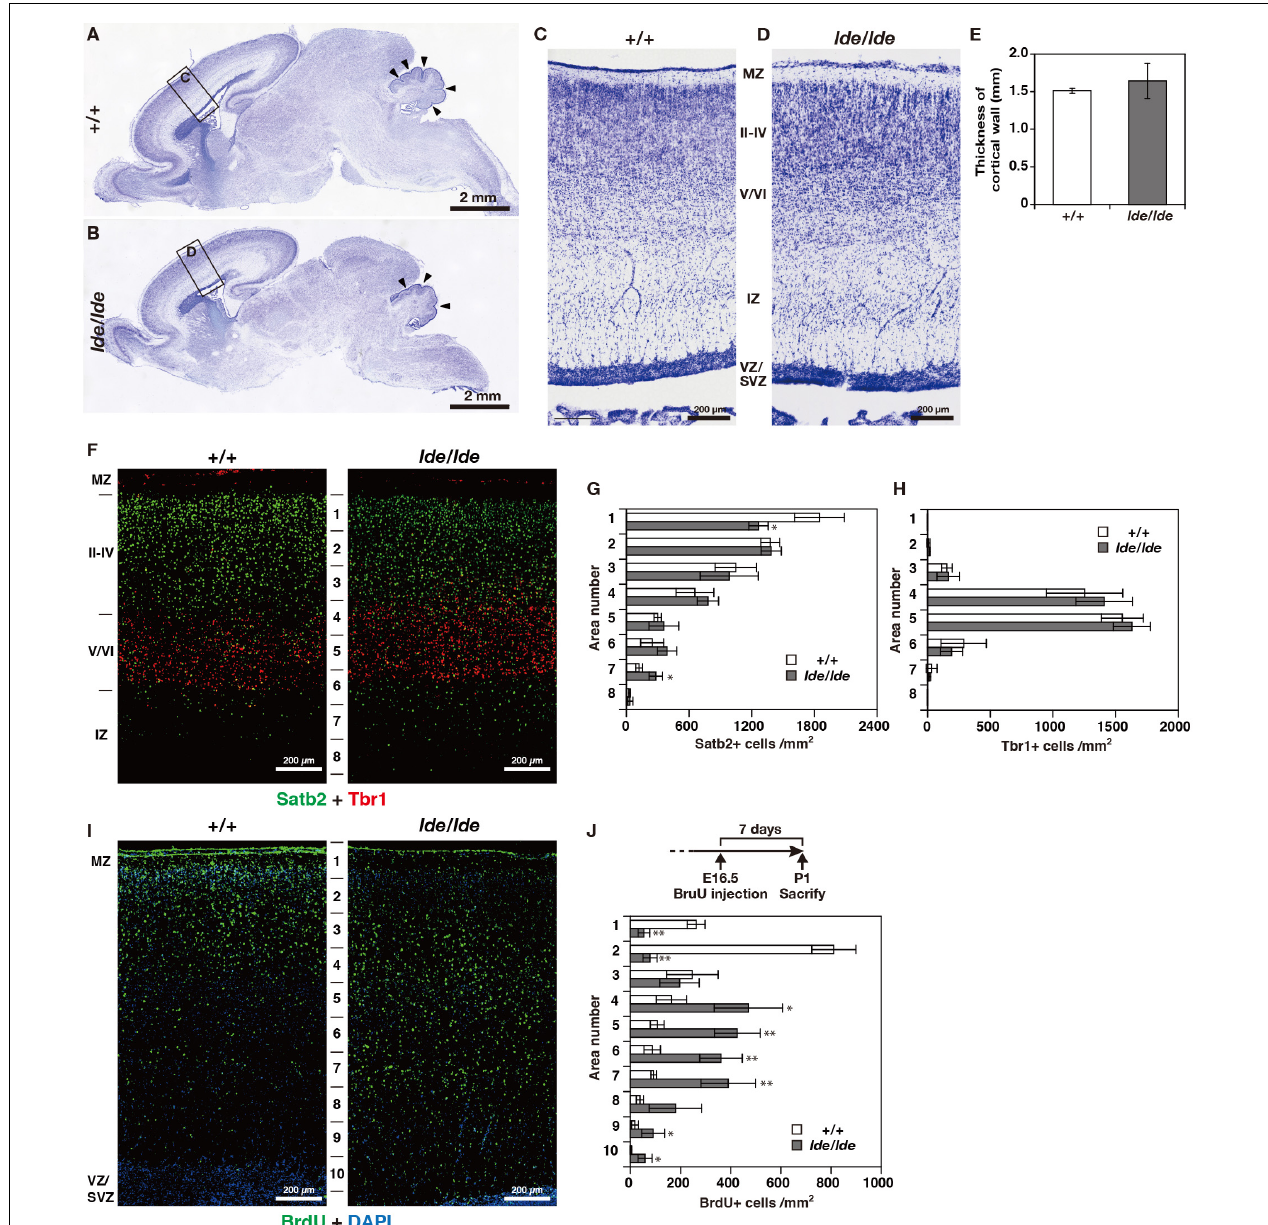
FIGURE 3 | Cortical layer formation and neural migration in lde/lde rat brain compared to normal one. (A–D) Sagittal brain sections at P1 rats were subjected to Nissl staining. Squares as labeled C and D in panels (A,B) indicated identical areas as shown in panels (C,D) , respectively. Arrowheads indicate delayed foliation in lde/lde cerebellum. (E) The thicknesses of cerebral wall (MZ to VZ/SVZ) is shown as mean ± S.D. from three independent experiments. Student’s t -test is used to determine statistical significance ( ∗ p < 0.05). (F) Sections are co-immunostained with anti-Satb2 (green) anti-Tbr1 (red). (I) Distribution of migrating neuronal cells labeled with BrdU (green) in cerebral cortex. Nuclei are counterstained with DAPI (blue). Representative images from three independent experiments are shown. The cell densities of Satb2 (G) , Tbr1 (H) , and BrdU-positive cells (J) in each area are plotted as histograms. Values are shown as the mean ± SD. The asterisk indicates a significant difference between +/+ and lde/lde in the same area by Student’s t -test ( ∗ p < 0.05, ∗∗ p < 0.01). Experimental scheme to label migrating cells by BrdU is illustrated in panel (J) . MZ, marginal zone; IZ, intermediate zone; VZ, ventricular zone: SVZ, subventricular